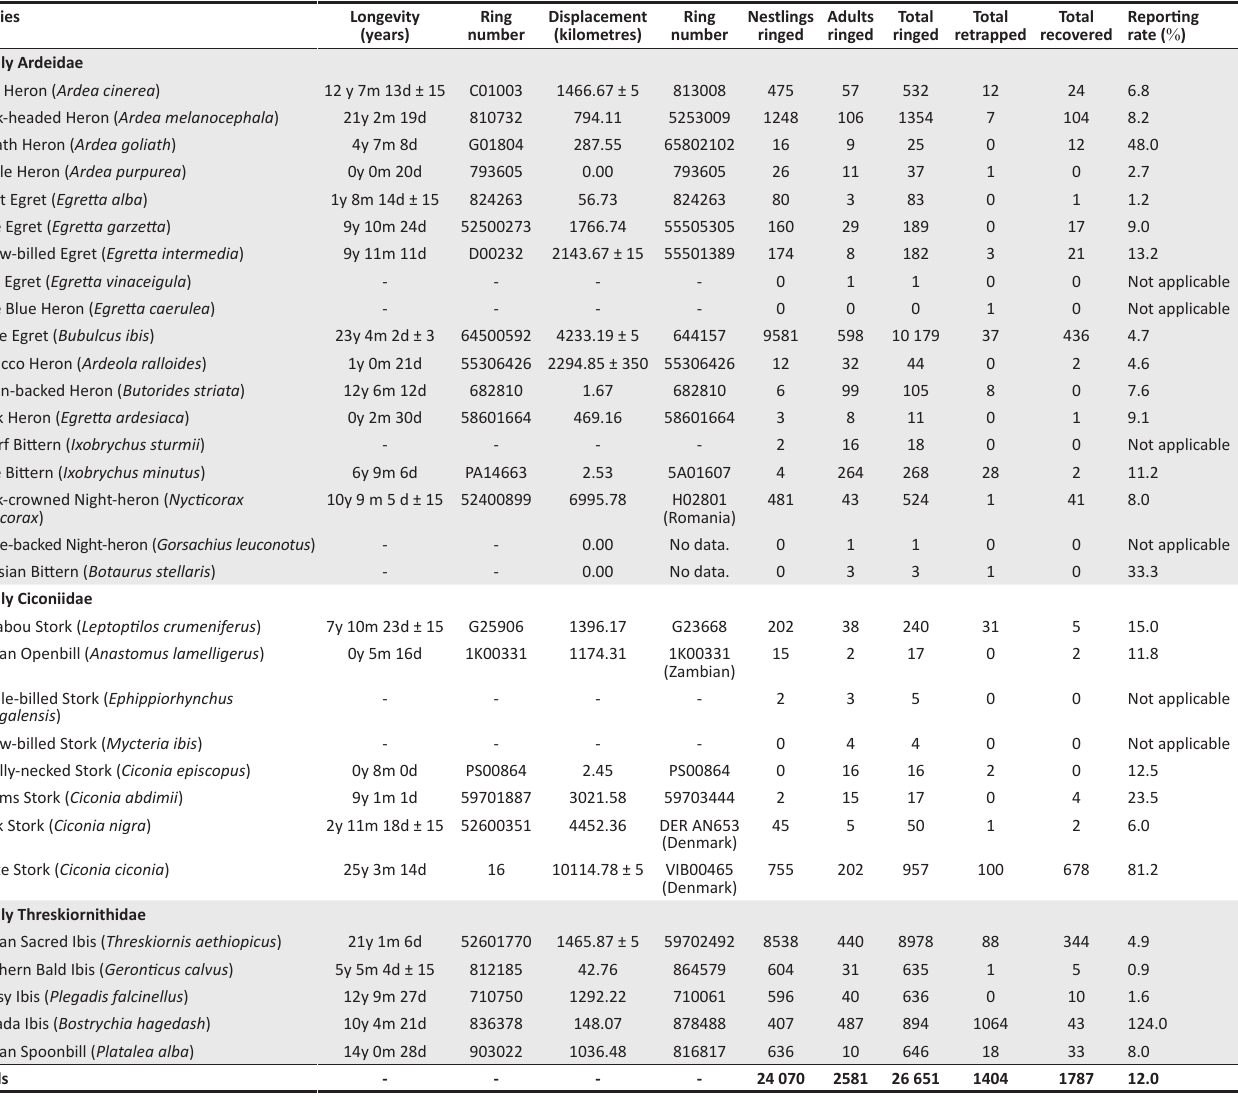
TABLE 1: Maximum longevity and displacement records of southern African Ardeidae, Threskiornithidae and Ciconiidae species from ringing records of the South African Bird Ringing Scheme.